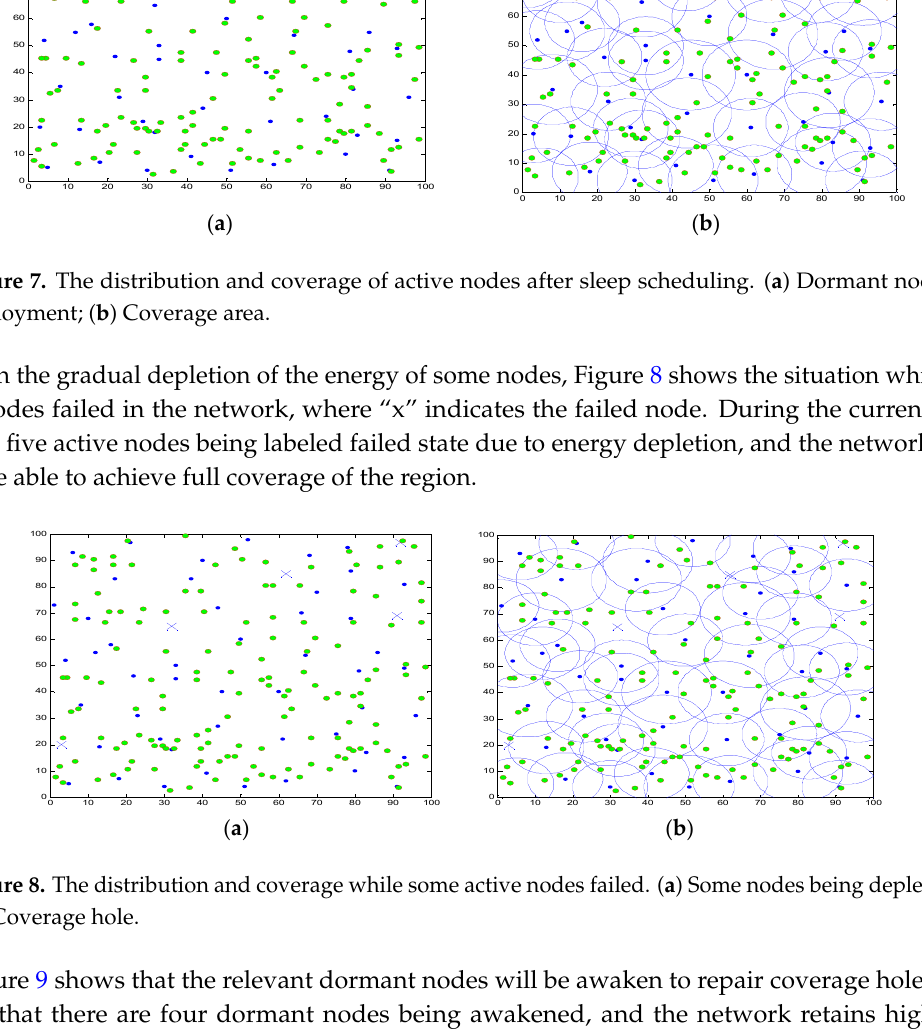
Figure 9. The distribution and coverage after some hibernated node being awaken. ( a ) Some hibernated node being awaken; ( b ) Coverage area .